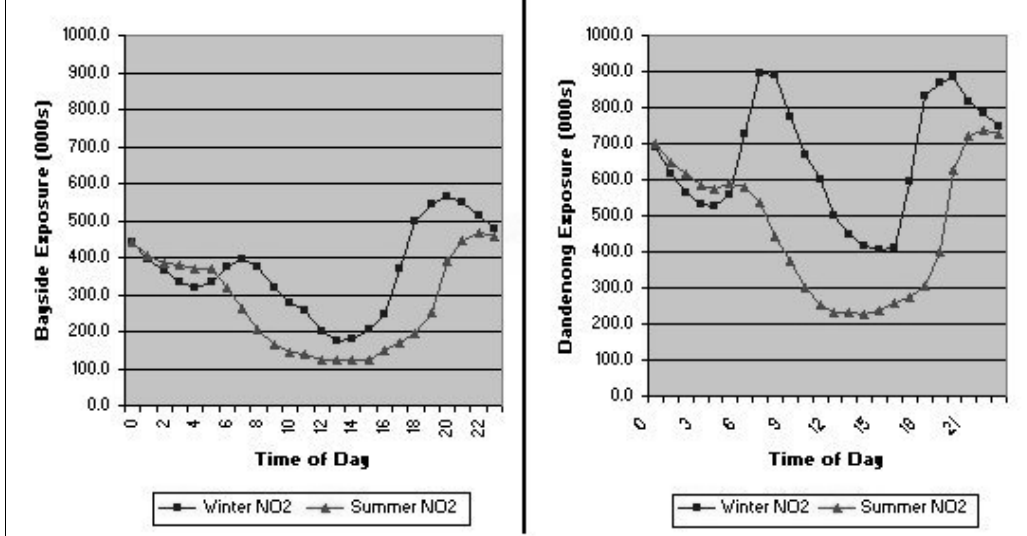
Figure 10. Seasonal NO